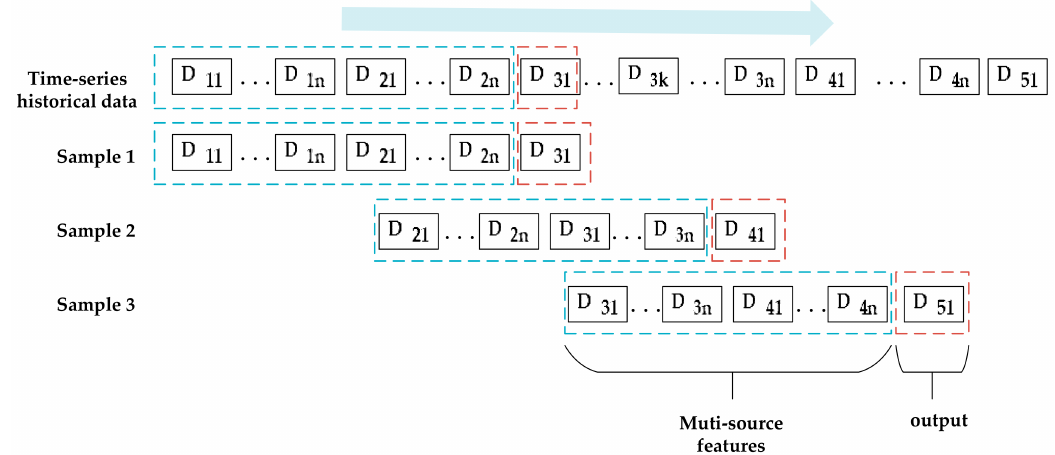
Figure 2. Examples of data